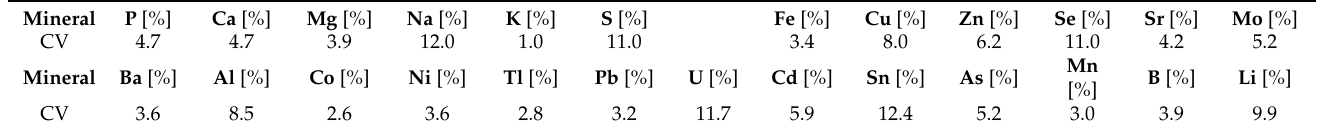
Table 1. Coefficients of variation (CV) for the analysis of macro and micro